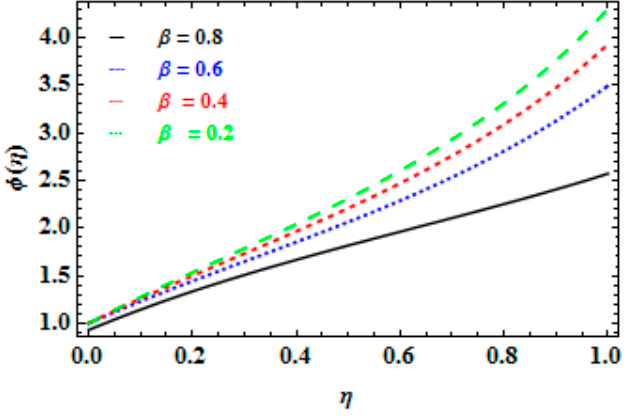
β β on 𝜙 ( 𝜂 ) . on 𝜙 ( 𝜂 ) .